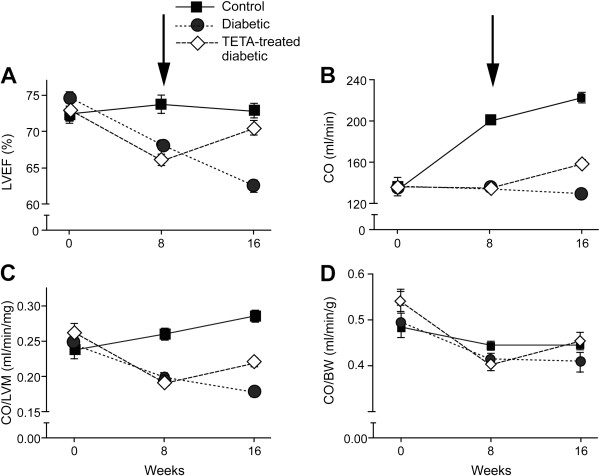
Time- and treatment-dependent changes in cMRI-derived cardiac functional parameters during the 16-week experimental period in groups of control (n = 12), untreated-diabetic (n = 12) and trientine-treated diabetic (n = 13) adult male rats. Drug treatment was initiated after the measurements of Week 8 (arrowed in A, B): A, LV ejection fraction (LVEF); B, LV cardiac output (CO); C, Ratio of CO/LV mass (CO/LVM); D, ratio of CO to body-weight (CO/BW). Abbreviation: TETA, triethylenetetramine.